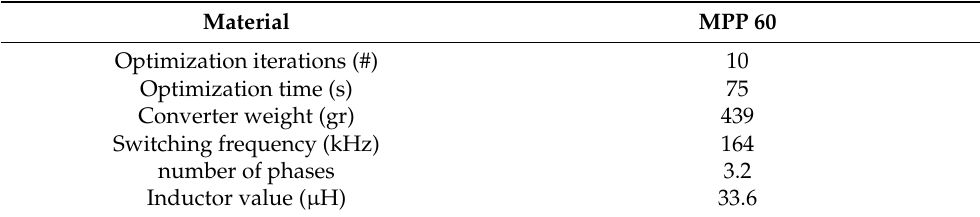
Figure 16. Optimizations in the imaginary world results for 8 different inductor core materials. Table 3. IBC optimal imaginary solutions for the initial set of specifications.